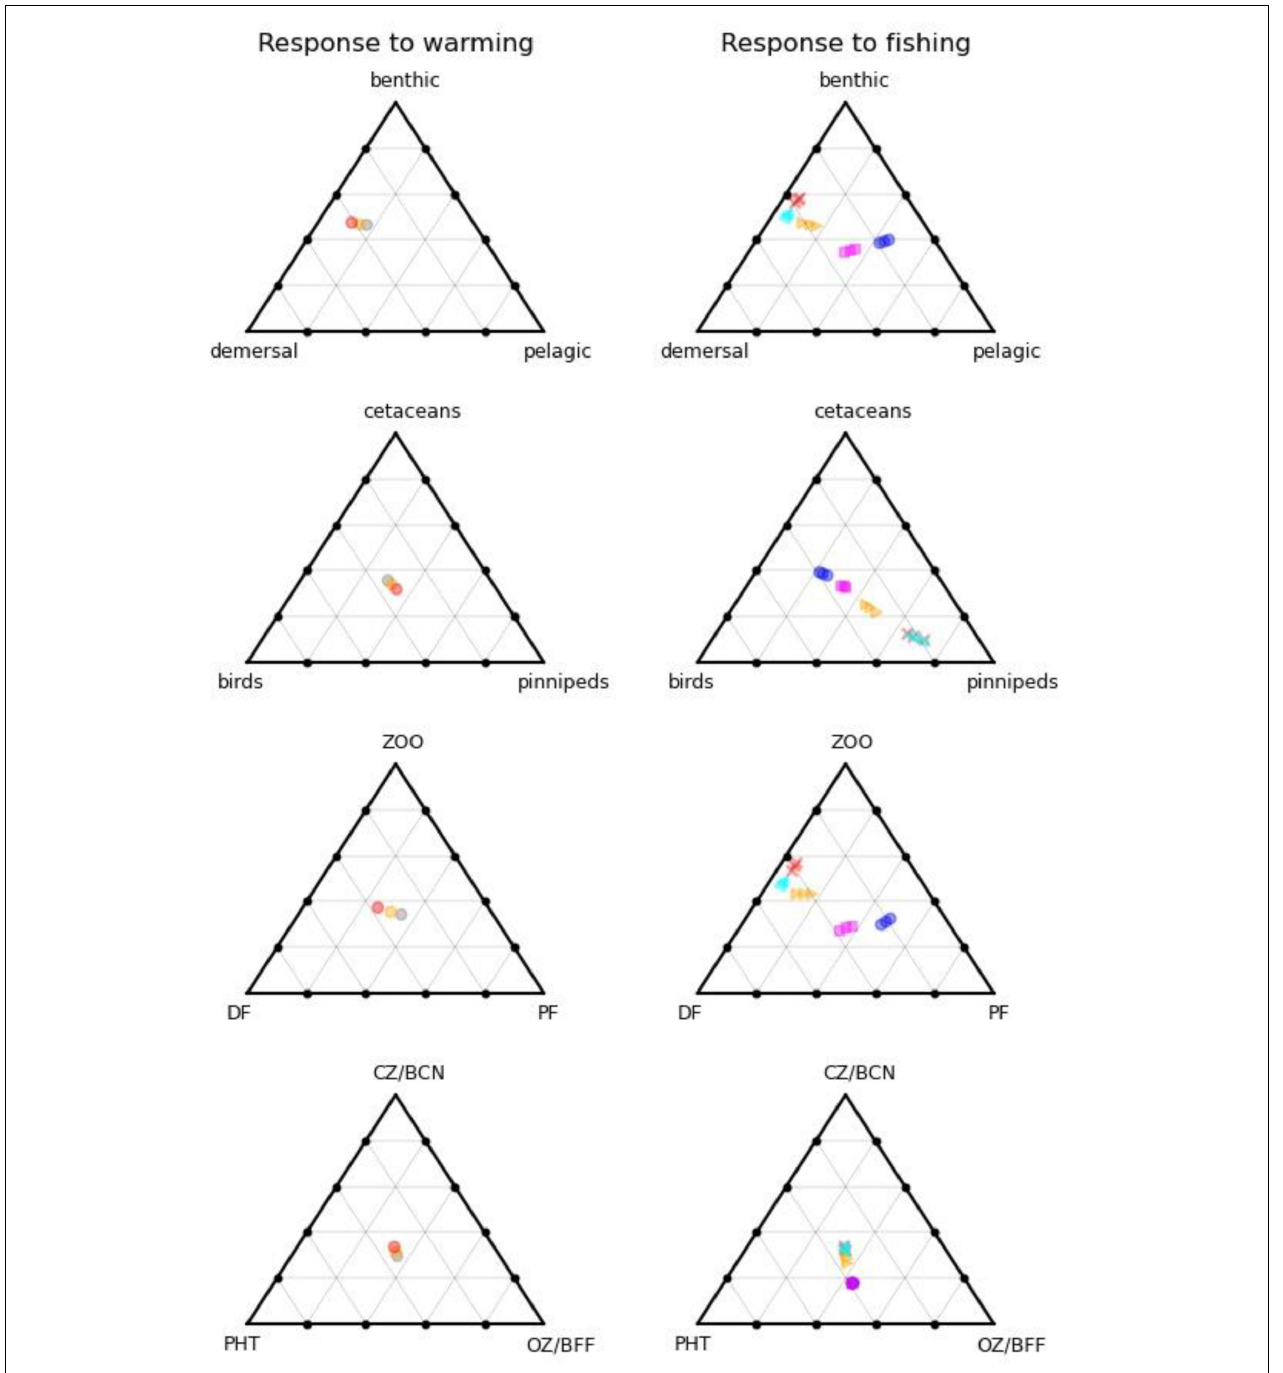
FIGURE 4 | Foodweb pathways of different ecosystem compartments as a function of warming (left) and fishing (right). On the left-hand side, grey dots are the reference climate, orange 2C warming, and red 4C warming, all for recent historic levels of fishing. On the right-hand side, magenta squares are unfished, cyan triangles low demersal fishing, blue circles low pelagic fishing, orange triangles medium (recent historic fishing), and red crosses high fishing, all for the reference climate. Different positions on the triangles indicate differences in the relative partitioning of biomass between the three categories considered.